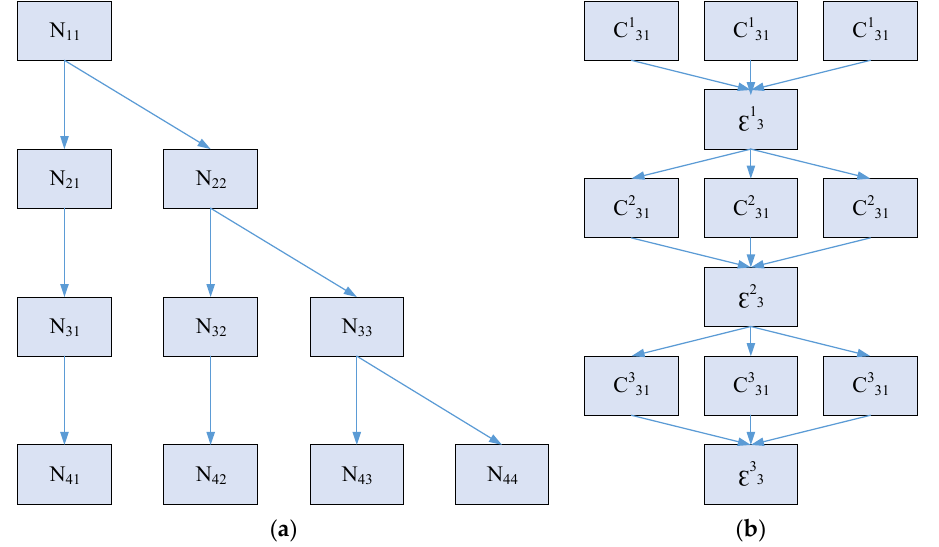
Figure 4. Basic network structure of HRNet [25]. ( a ) Parallel network structure. ( b ) Scale fusion network structure. ( N sr represents the subnet in the s stage, and its resolution is 1/(2 r − 1 ) of the image in the initial stage. C srb represents the b switching block of the s stage, and the resolution of its switching unit is 1/(2 r − 1 ) of the initial stage, while ε sb represents the corresponding switching unit.) Global branching introduces switching units across parallel subnets so that each sub- net receives information from other subnets multiple times. An example of an information exchange unit is shown in Figure 4b, where stage 3 is divided into multiple switching blocks. Each switching block consists of three parallel convolutional units and one switch- ing unit. The specific implementation of aggregation of feature information of different resolutions by exchanging units in GL-HRNet is shown in Figure 5.